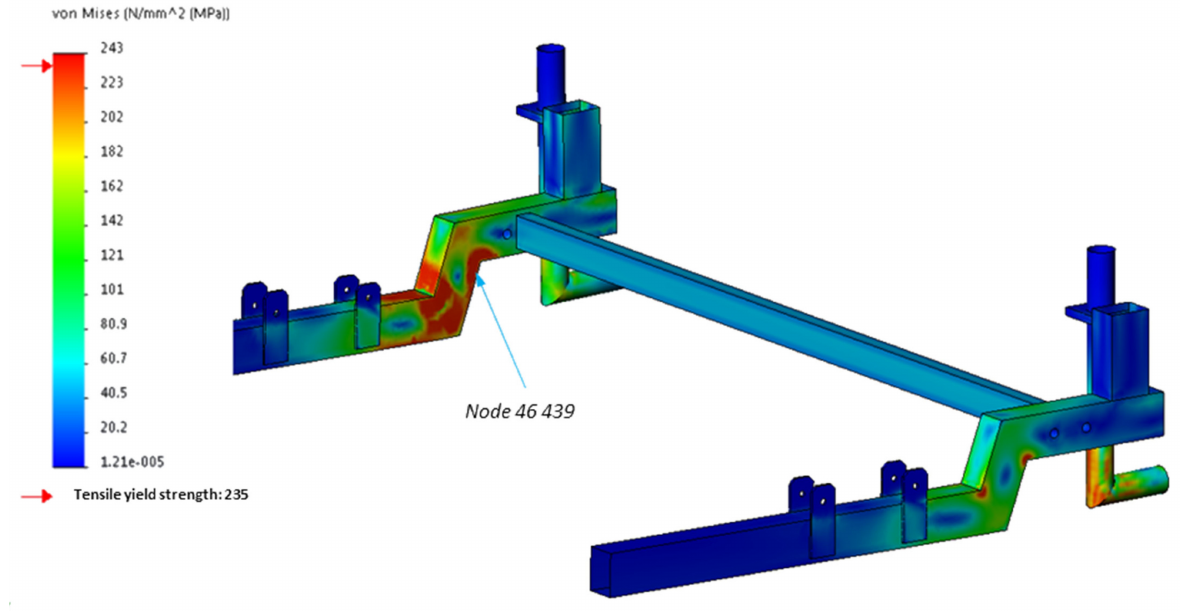
Figure 8. Stress in the original ASC crossbar in case of collapse. To obtain the load degree value for the limit state of stability of L Fst , tangents to the elastic and plastic part of the curve were drawn and the value of the Load Factor at their intersection point (Figure 9) was read. The value L Fst from the GMNA analysis for the stability limit state of the original frame solution is